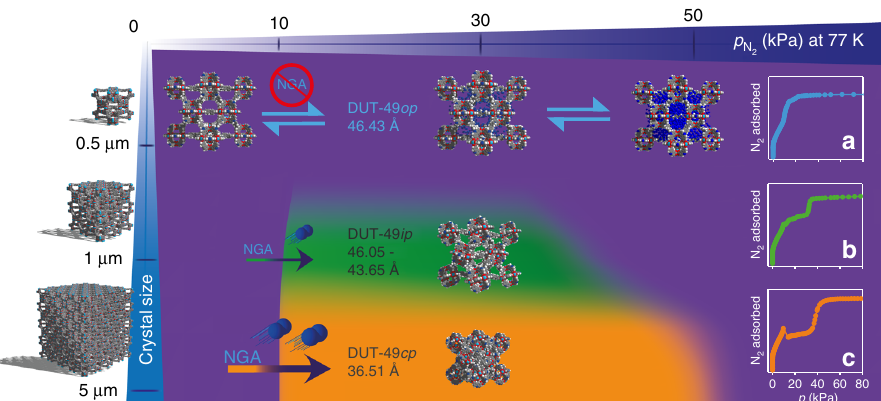
Fig. 4 Phase transitions of DUT-49 depending on crystal size and pressure during adsorption of nitrogen at 77 K. Structural representations are given for the observed phases corresponding to unit cell parameters given in the caption of Fig. 2. Nitrogen adsorption isotherms at 77 K for a DUT-49( 12 ), b DUT- 49( 10 ) and c DUT-49( 4 ) representing the three